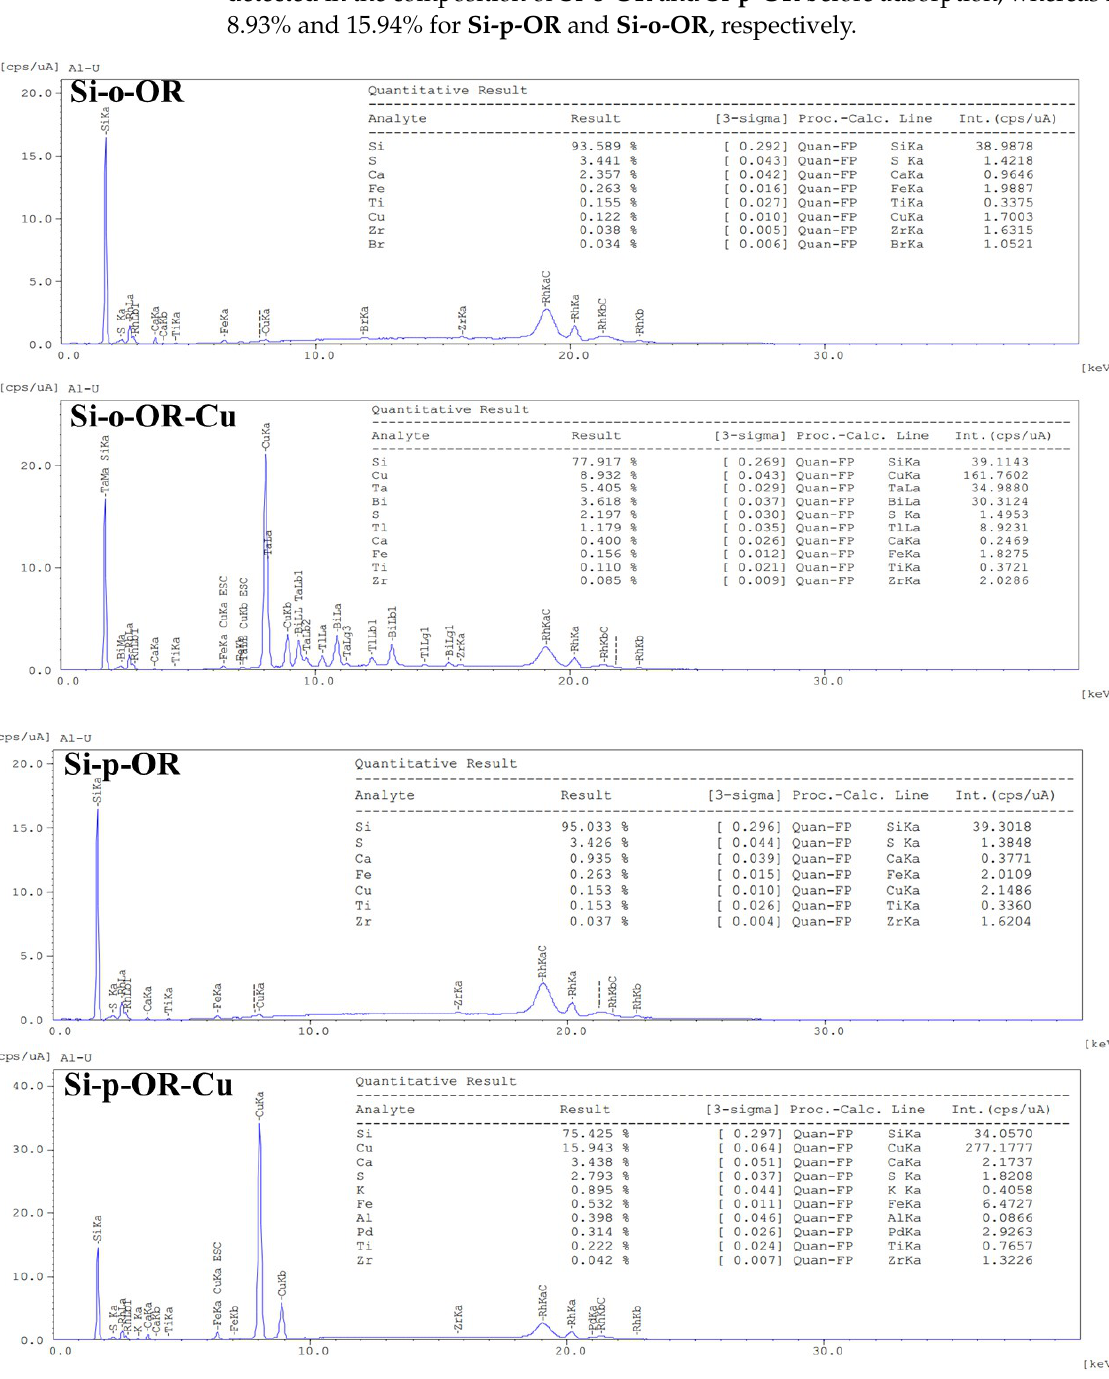
Figure 11. EDX spectra of Si-o-OR and Si-p-OR (before adsorption) and Si-o-OR-Cu and Si-p-OR-Cu (after adsorption of Cu(II)).